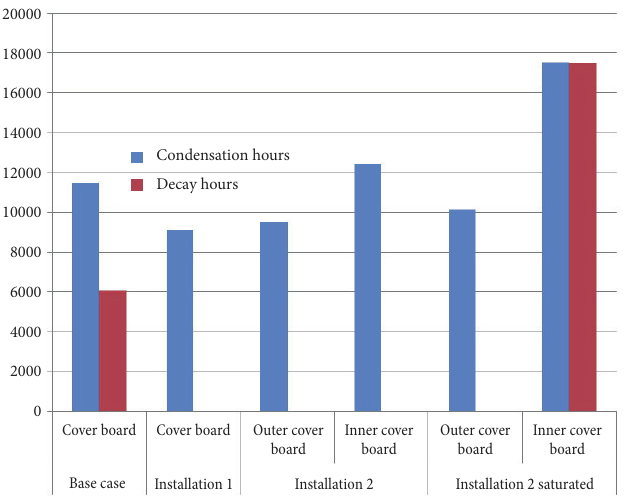
Fig. 6. Two dimensional results for condensation and decay